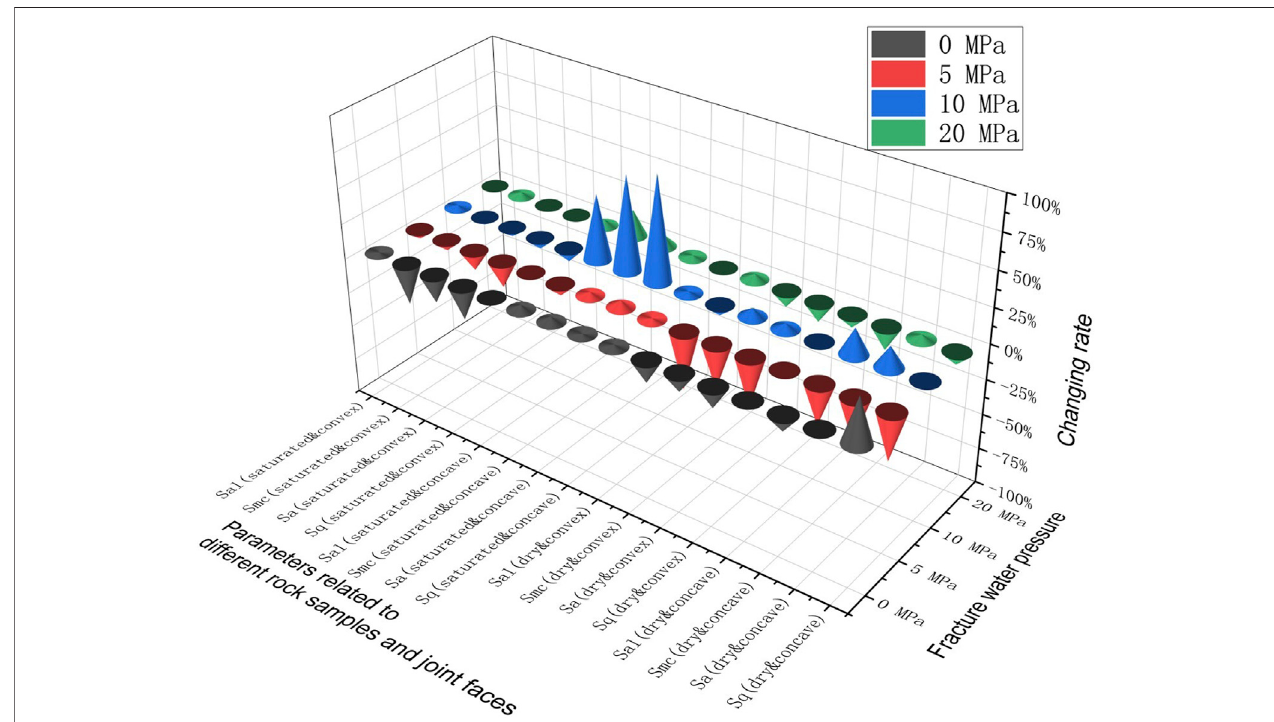
FIGURE 4 | Comparison of the change rates of morphological parameters with different samples and joint surfaces.